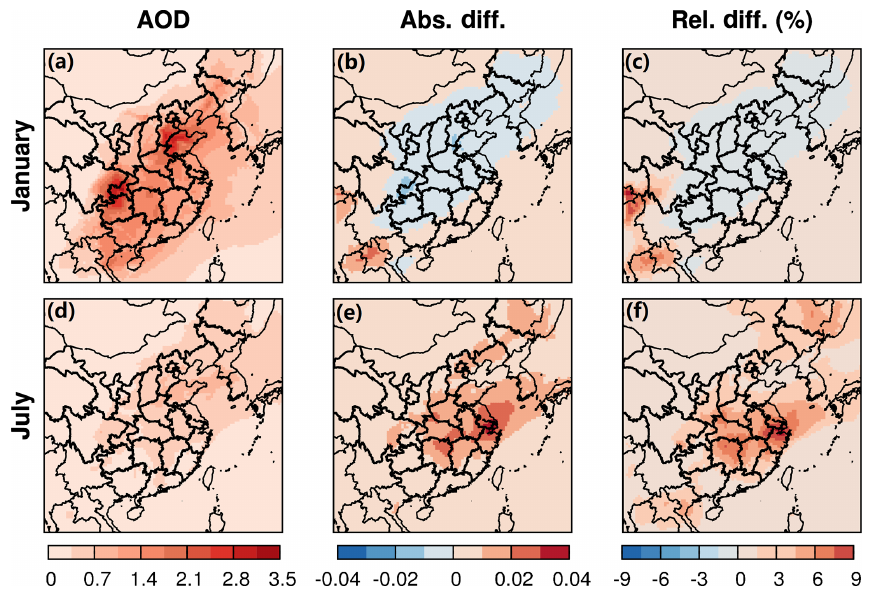
Figure 5. Monthly averaged AOD r at 550nm and changes in AOD r due to water partitioning into OPM and nonideality of the organic–water mixture. “Abs. Diff.” represents absolute differences (C3–BC); “Rel. Diff.” represents relative differences ((C3–BC)/BC; %).